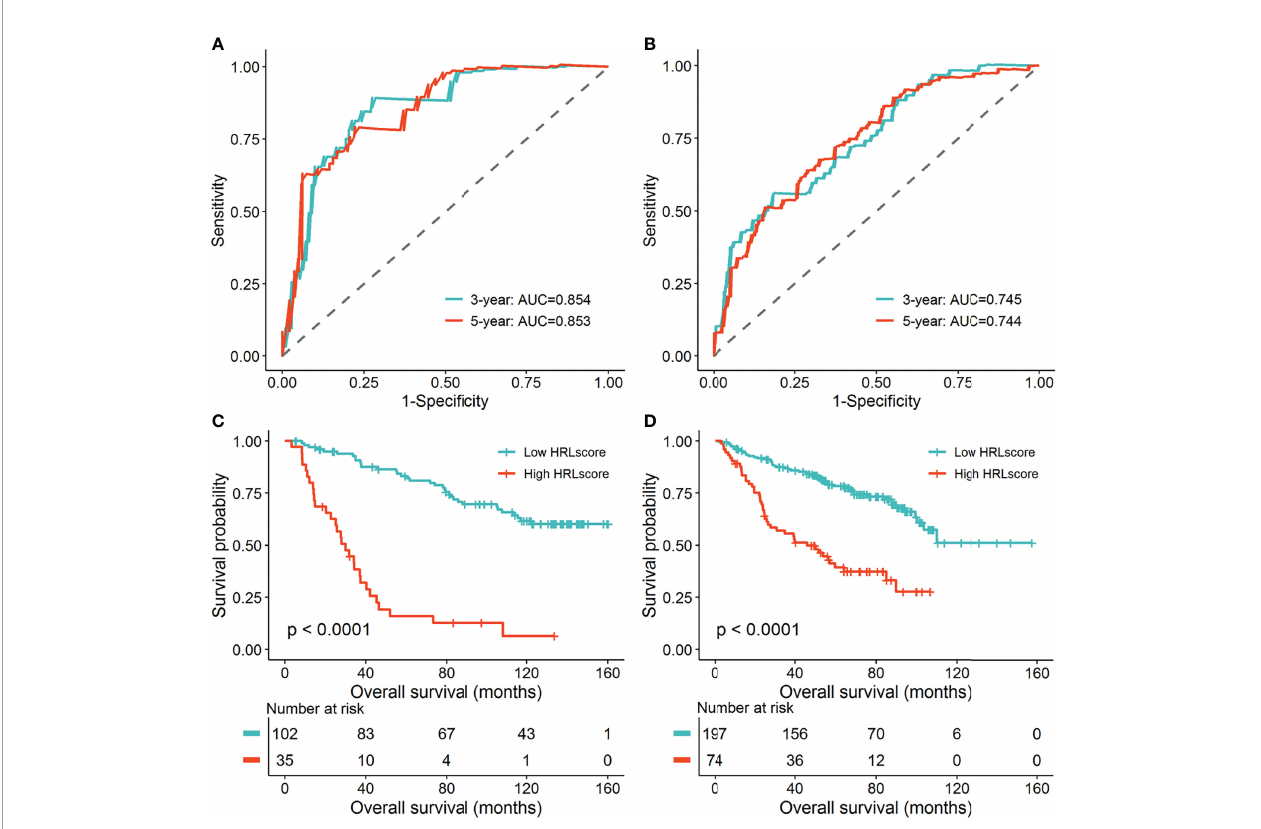
FIGURE 3 | Validation of the HRL signature in the CGGA database. (A) Time-dependent ROC curves for patients in the CGGA-325 cohort. (B) Time-dependent ROC curves for patients in the CGGA-693 cohort. (C) Survival curves for patients in the CGGA-325 cohort. (D) Survival curves for patients in the CGGA-693 cohort.